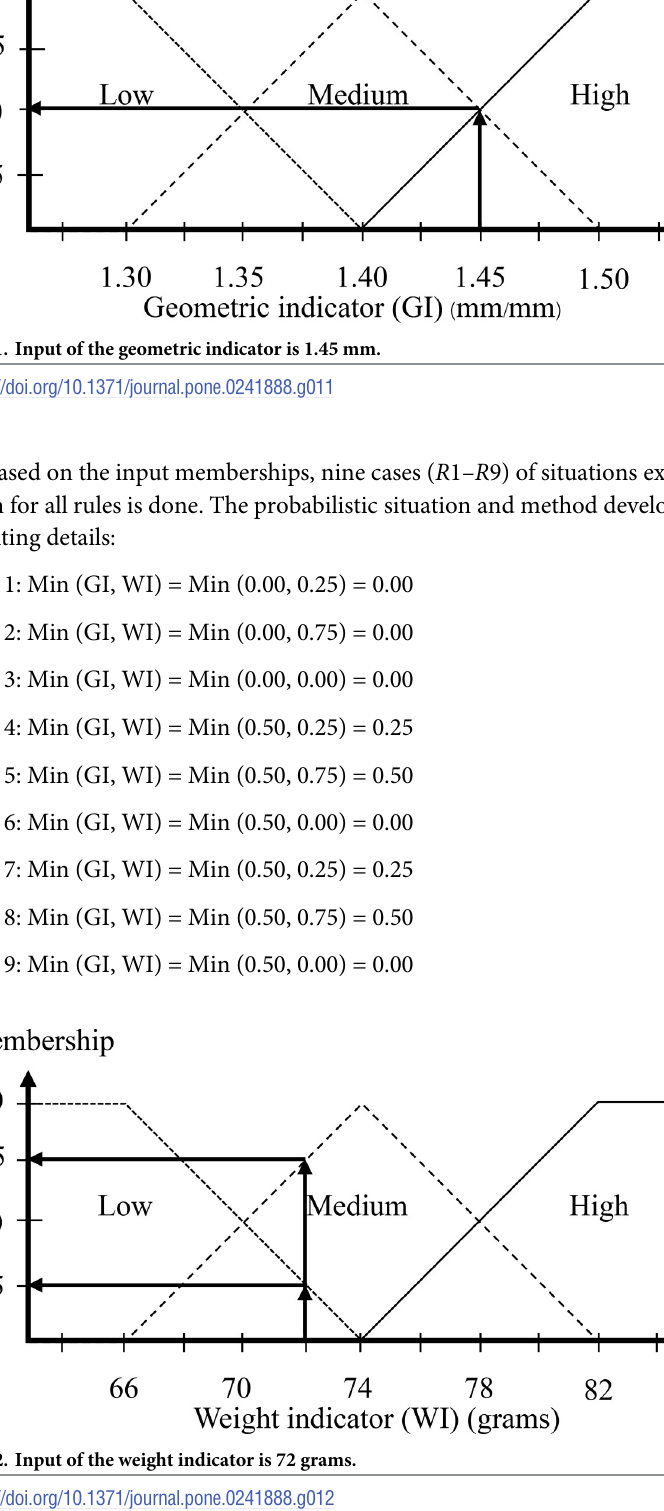
Fig 11. Input of the geometric indicator is 1.45 mm.